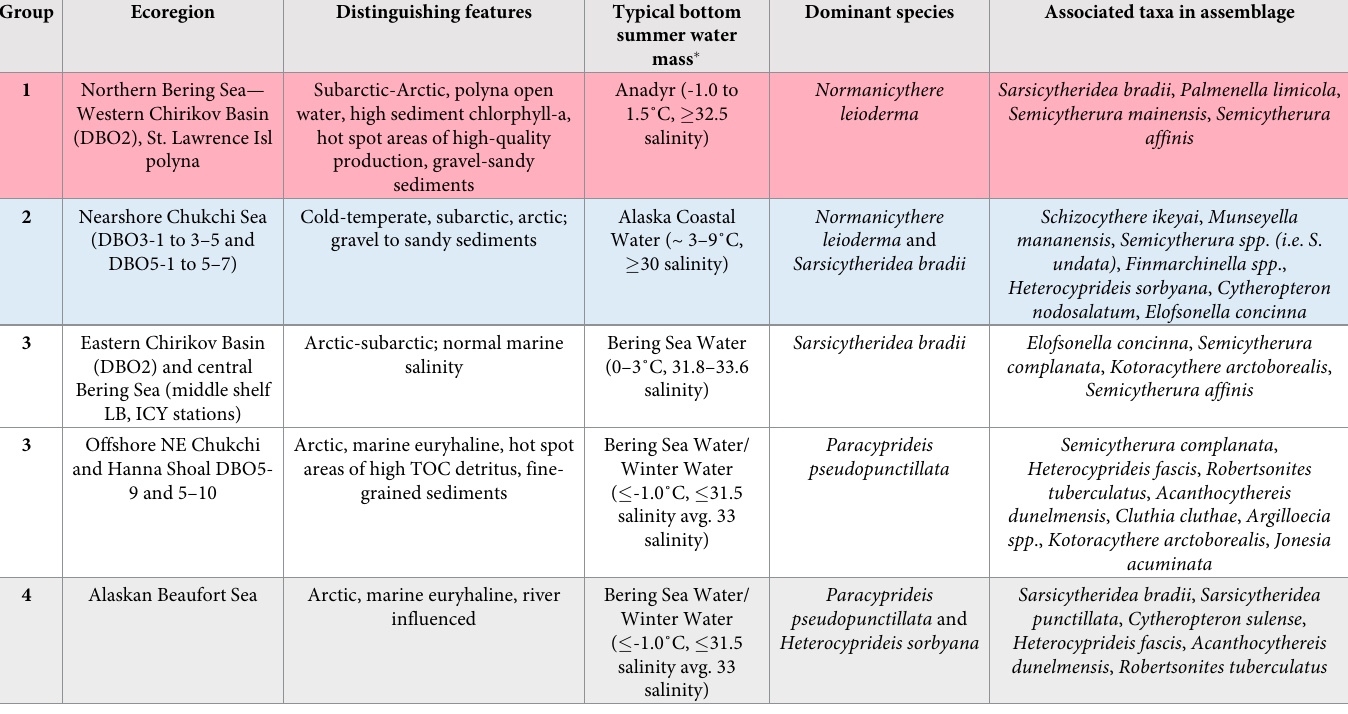
Table 3. DCA results based on the relative abundance of 49 ostracode species (including three genera, Argilloecia , Cytheropteron and Semicytherura ) in 289 surface sediment samples from continental shelf regions of the Bering Chukchi and Beaufort Seas collected primarily in summer 1970–2018.